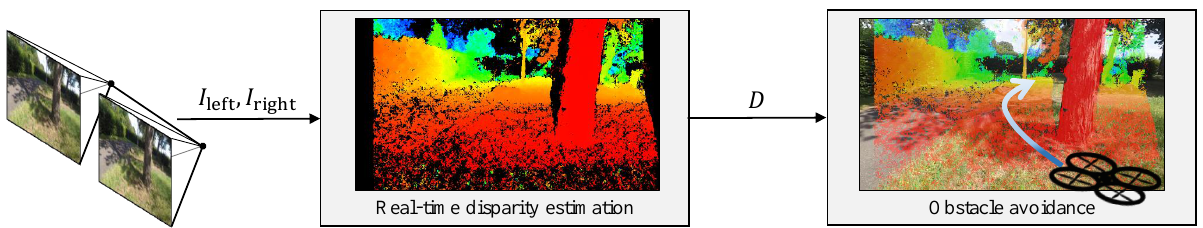
Figure 1. Overview of our system for real-time on-board obstacle avoidance based on embedded stereo. We use a stereo camera system to acquire two input images I left and I right . These are passed to the first processing stage, where a disparity map D is computed in real-time on an embedded FPGA. This disparity map is used by the subsequent step to compute and execute an evasion manoeuvre in order to avoid obstacles in the flight